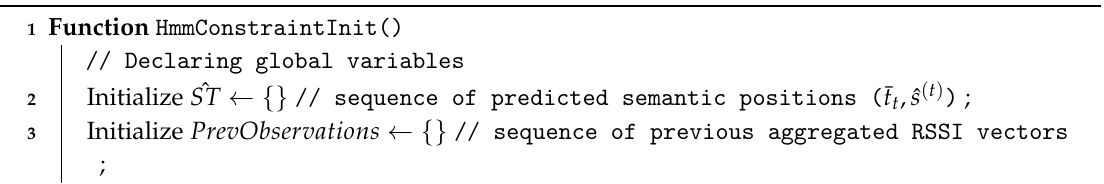
Algorithm 1: Initialization algorithm of Hidden Markov Model (HMM) with